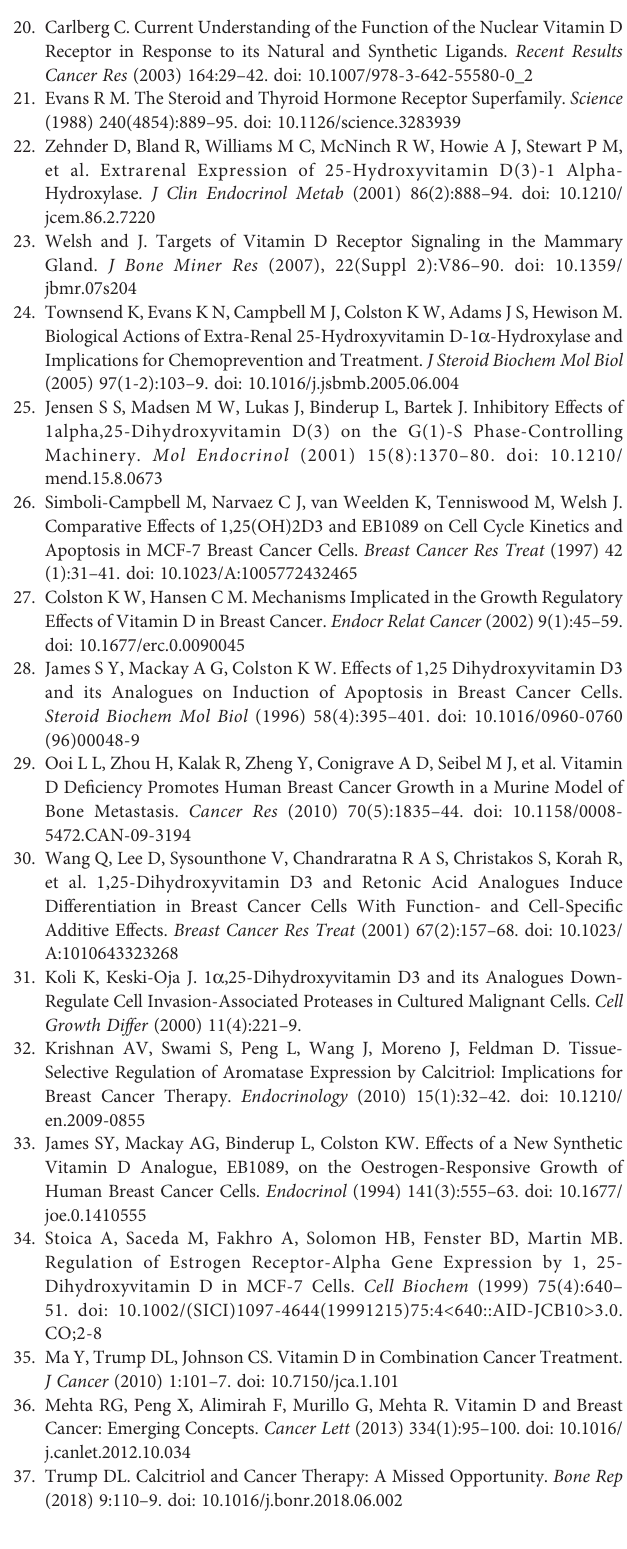
Supplementary Table 1 | Key VM-related genes and signaling pathways in Breast cancer cells that are differentially regulated by Vitamin D signaling. The adjusted p-value, odds ratio, and the combined score are shown for each